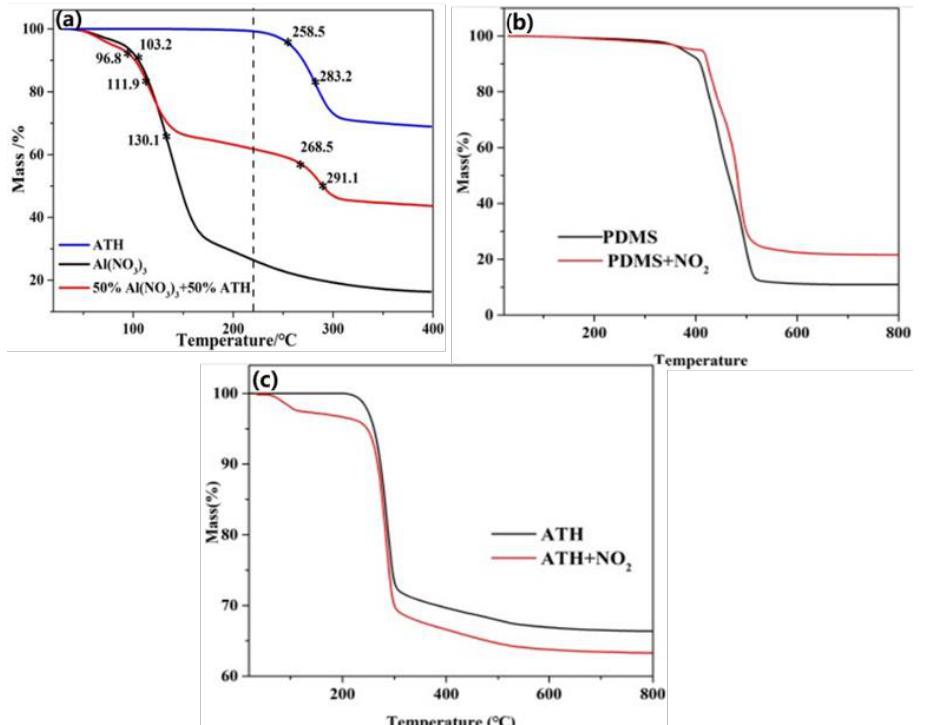
Figure 11. Thermogravimetric curve of ATH, Al(NO 3 ) 3 and their mixture ( a ), thermogravimetric curve of PDMS and PDMS aged for 36 h by NO 2 ( b ), and thermogravimetric curve of ATH and ATH aged for 36 h by NO 2 ( c ).